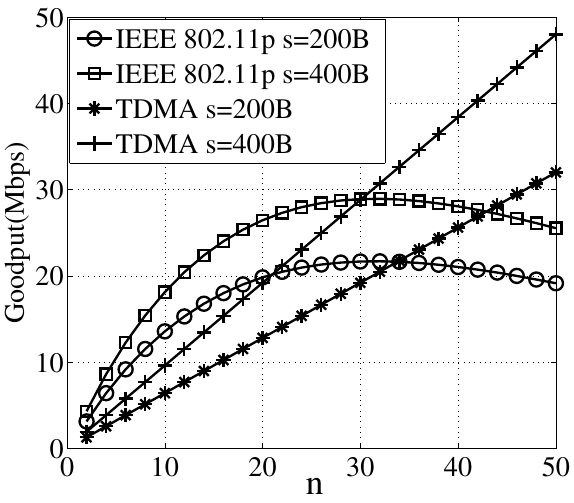
Figure 3. Network goodput with different number of